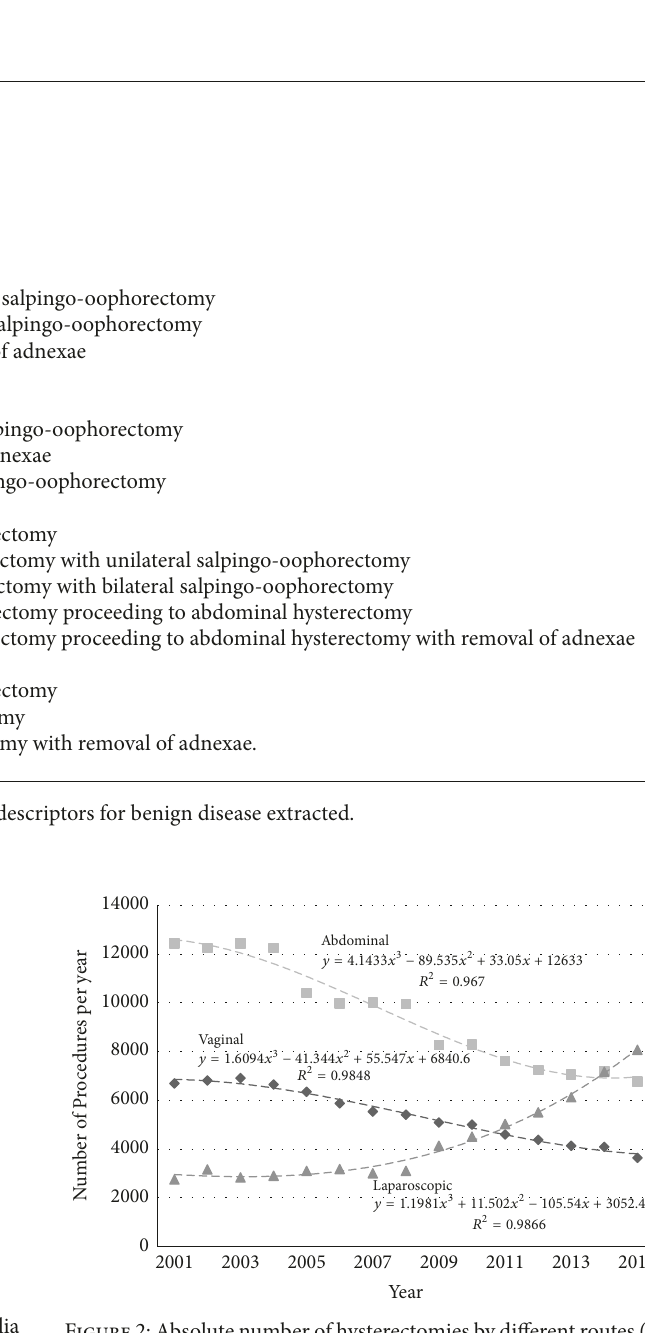
Figure 2: Absolute number of hysterectomies by different routes ( X vaginal, ◼ abdominal, and 󳵳 laparoscopic) in Australia in women aged 35–54